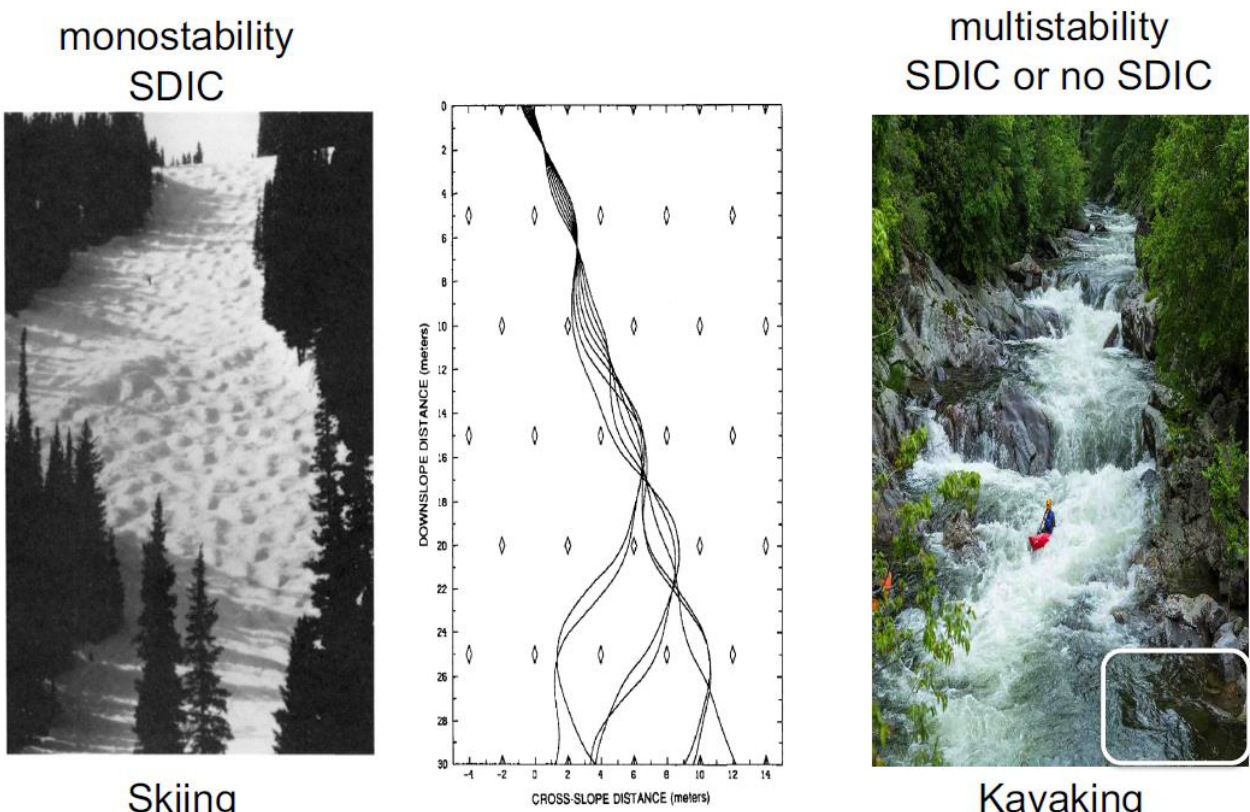
Figure 1. Skiing as used to reveal monostability (left and middle, Lorenz 1993 [3]) and kayaking as used to indicate multistability (right, courtesy of Shutterstock-Carol Mellema https://www.shutterstock.com/image-photo/kayaker-enjoys-whitewater-sinks-smoky-mountains-649533271 (accessed 1 November 2022)). A stagnant area is outlined with a white box.